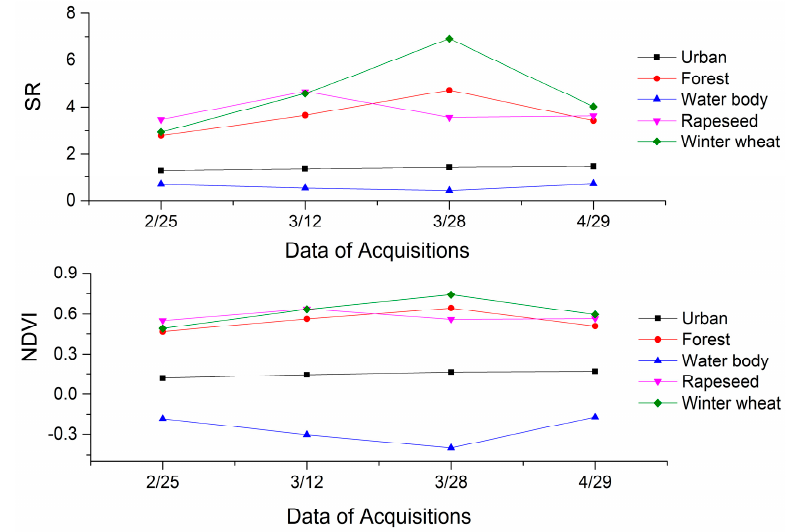
Figure 4. Average SR and NDVI values for each land cover class on four image acquisition